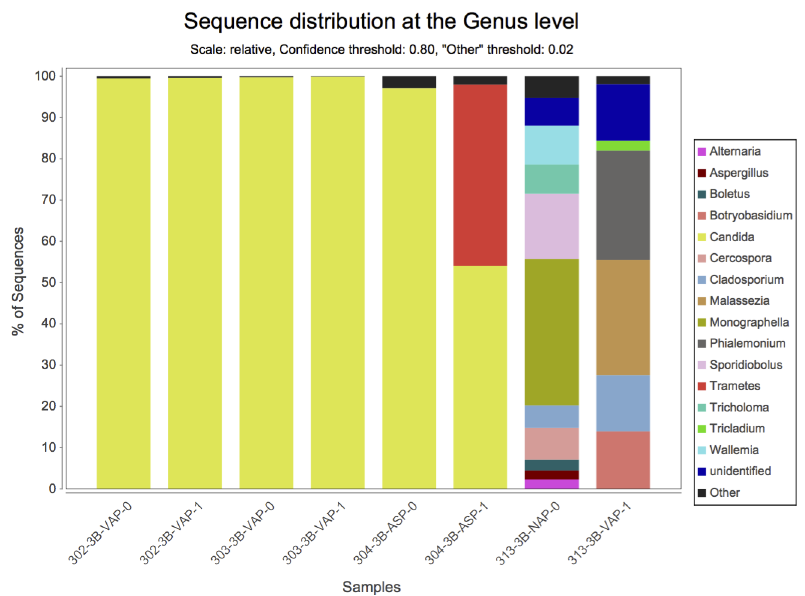
Fig 10. Relative abundance of fungal microbiota in consecutively sampled patients. Consecutive lower respiratory tract samples of 4 intubated and mechanically ventilated patients with pneumonia. Fungi are shown at genus level. Yellow bars represent Candida species. VAP = Ventilator associated pneumonia, ASP = aspiration pneumonia, NAP = nosocomial acquired pneumonia.